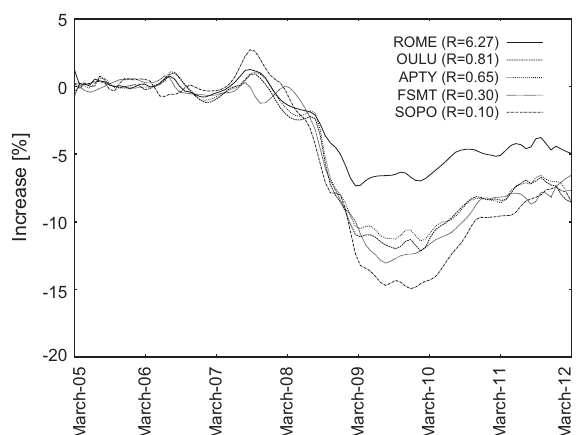
Fig. 4. Time profiles of the cosmic-ray intensity during the March 7th event, as it was recorded by a number of neutron monitors with different rigidity: Rome, Oulu, Apatity (APTY), Fort Smith (FSMT), and South Pole (SOPO).